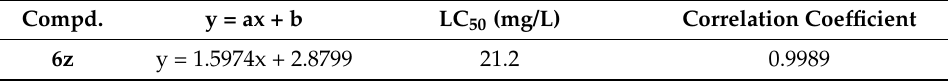
Table 3. LC 50 value of 6z against Plutella xylostella .